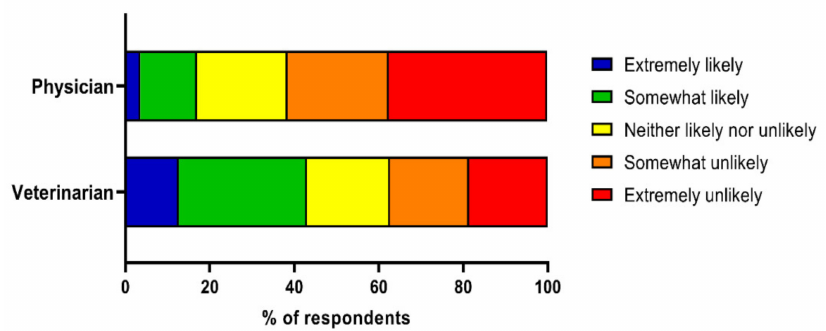
Figure 3. Likelihood of participants contacting their physician and veterinarian for information about zoonotic